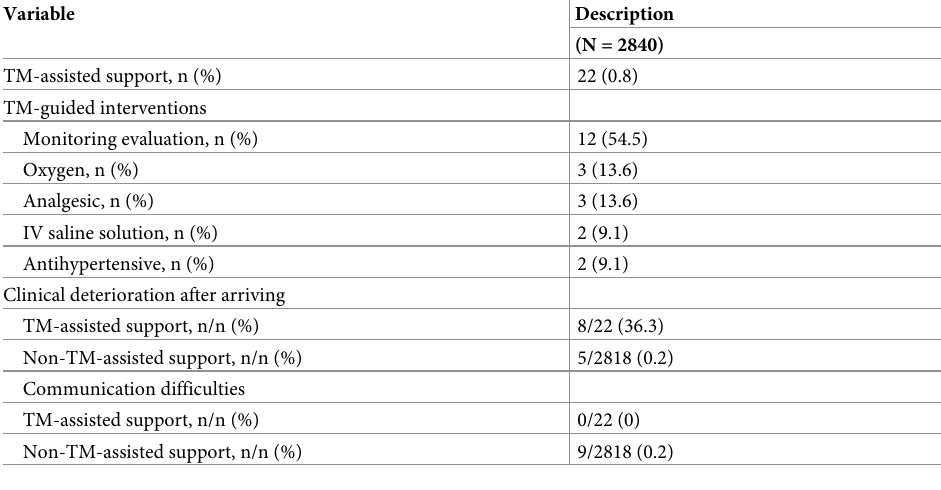
Table 2. Telemedicine-assisted transport